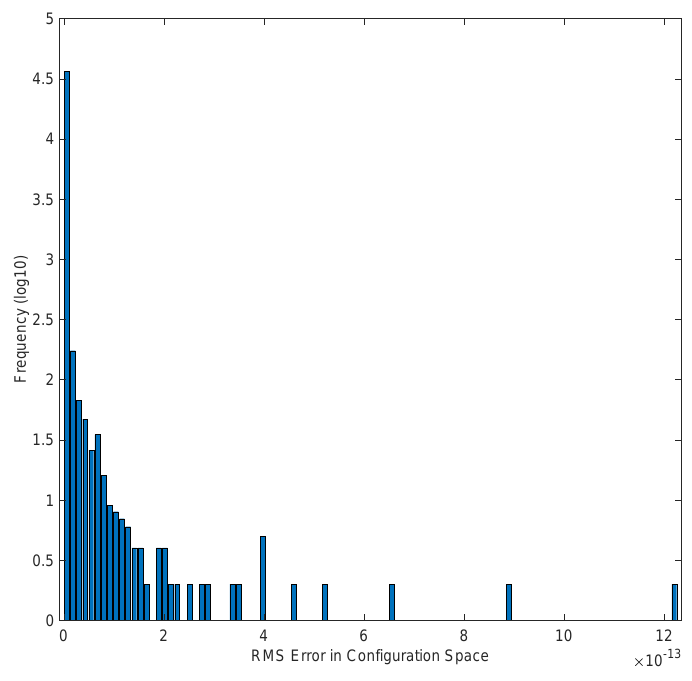
Figure 8. Histogram of the RMS errors in the computations of the PUMA’s IKM. The x -axis presents a partition of 100 sets of the obtained RMS errors for all the calculated points inside the PUMA’s workspace, while the y -axis shows the frequency of occurrence of each of these error sets, in a logarithmic scale. The majority of the obtained RMS errors fall inside the first sets, the ones that represent less error. It can also be seen that the higher sets still represent a completely negligible error.